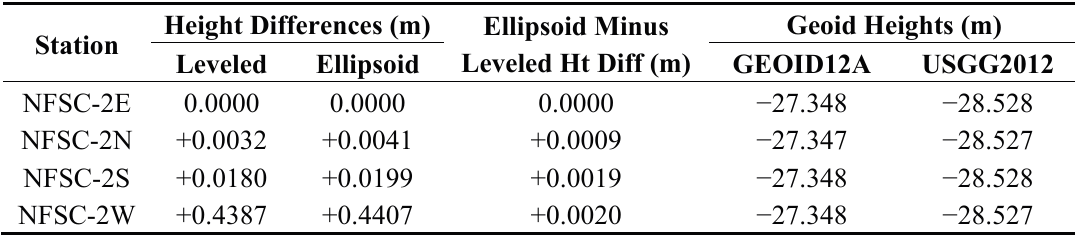
Table 1. Leveled heights of study site monuments (Phase 1) with respect to the lowest station (NFSC-2E) [18].